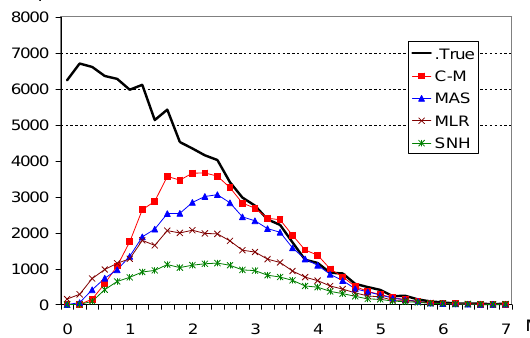
Figure 2. The same as Fig. 1, but 5Pfm (i.e. 10 change-points of platform-like IHs) per 100yr are included in time series instead of persistent shifts. Length of platforms has equal distribution between 1 month and